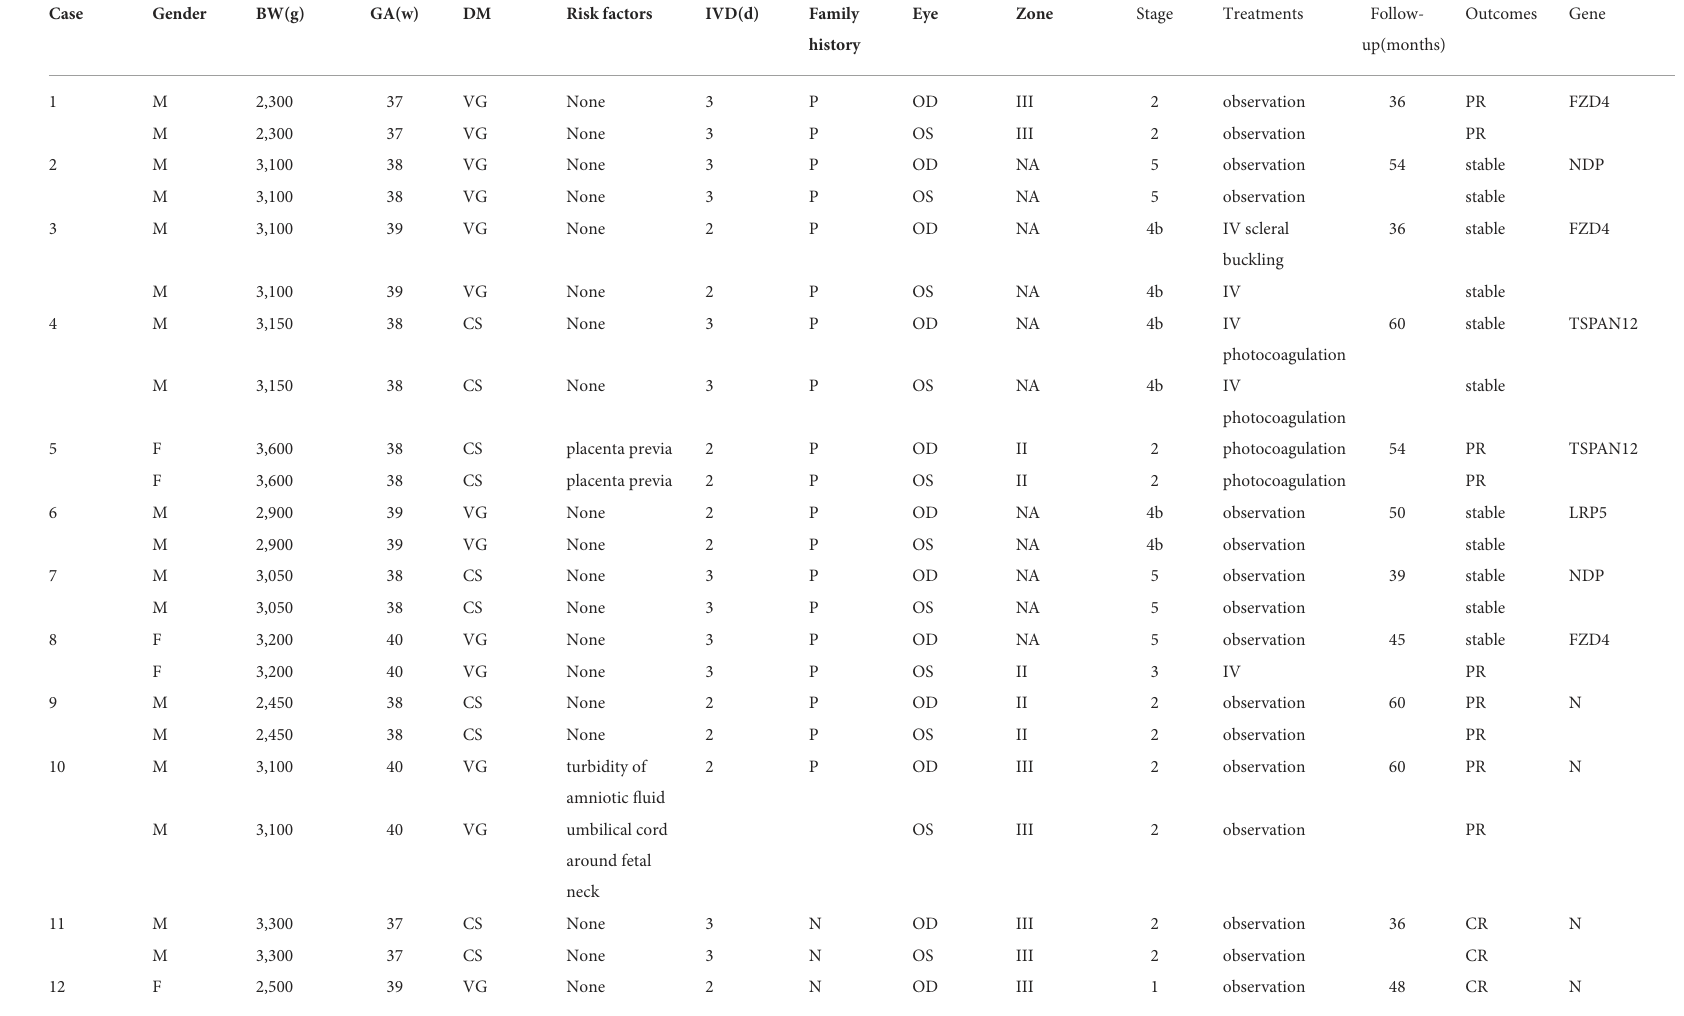
TABLE 1 Demographic and clinical features, risk factors and treatment of newborns with ROP-like